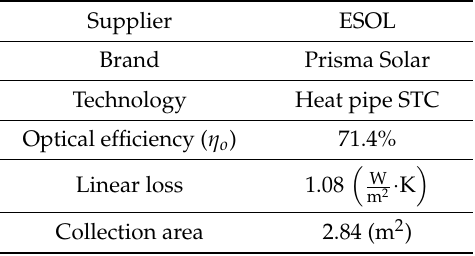
Table 5. Technology used for solar thermal collectors